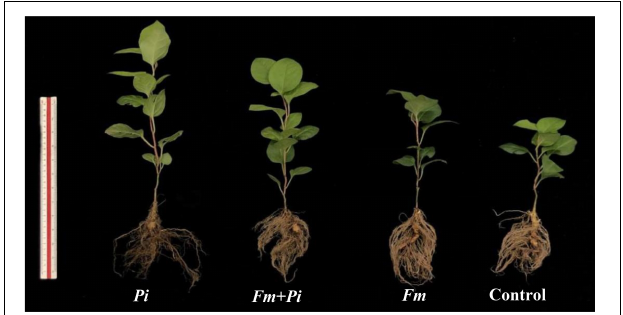
FIGURE 2 | Plant growth responses of Polygonum cuspidatum Sieb. et Zucc to Funneliformis mosseae ( Fm ) and Piriformospora indica ( Pi ) single or in